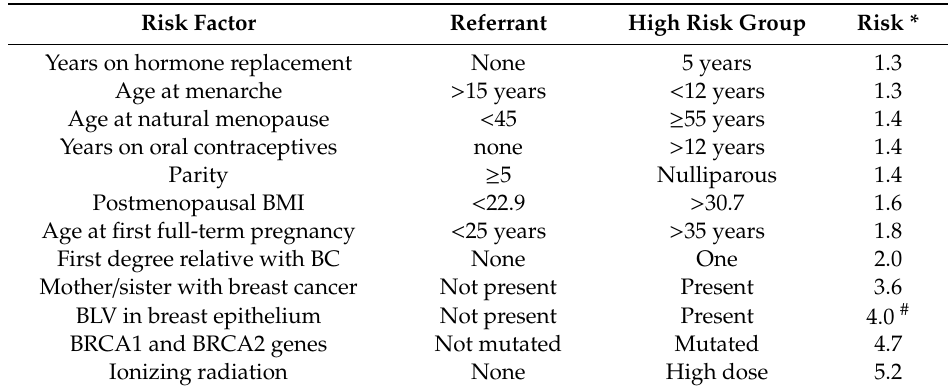
Table 2. Hill Criterion #1: relative strengths of breast cancer risk